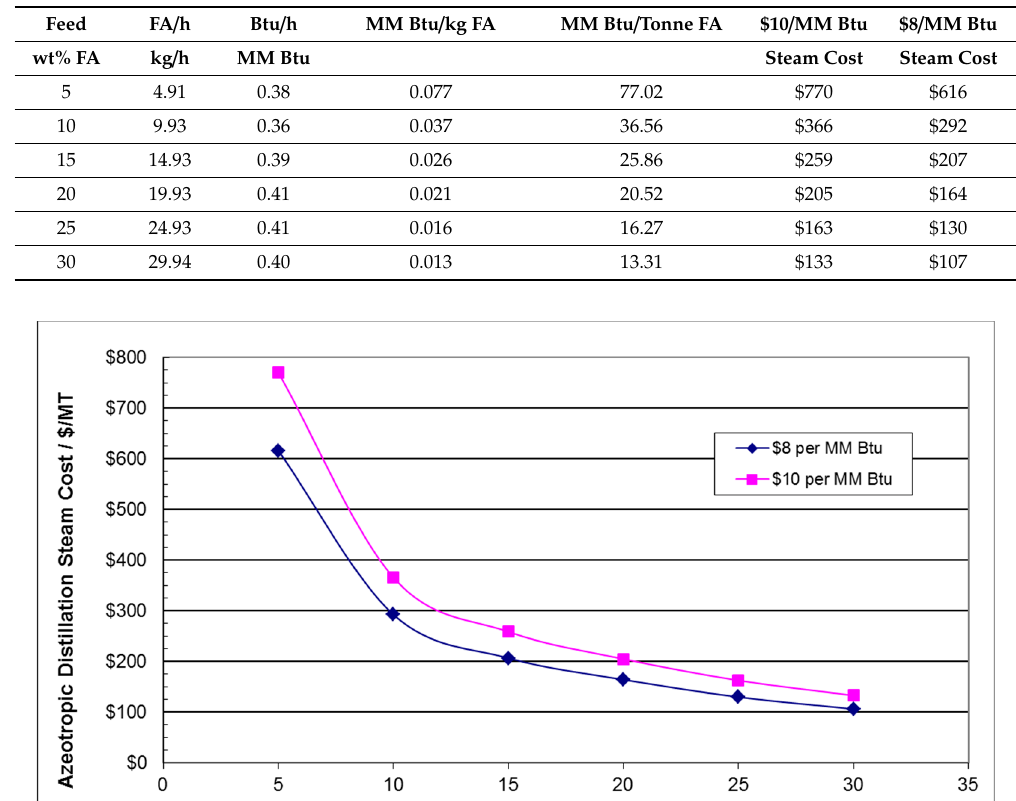
Table 7. Calculated steam cost for azeotropic distillation based on various FA wt% solution feedstocks per the conditions and configuration shown in Supplementary Materials Section S2 at steam values of $8 and $10 per MM Btu.